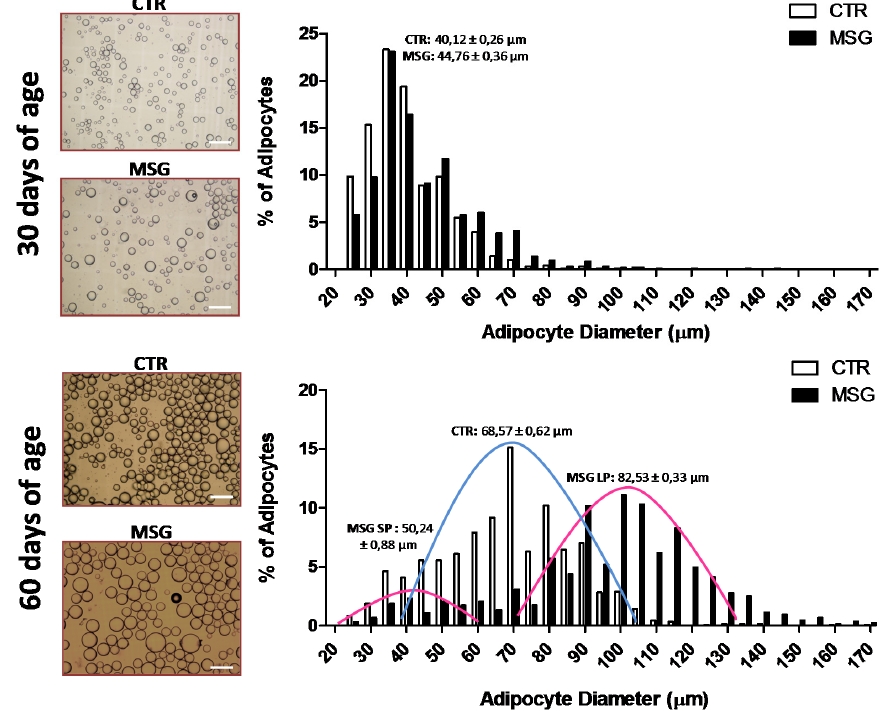
Figure 6. In vivo adipogenesis occurs in MSG animals. Adipocyte size distribution in RPAT depot from CTR and MSG rats at 30 (upper panel) and 60 days of age (lower panel). Purple and blue lines represent MSG (MSG SP: MSG small population; MSG LP: MSG large population) and CTR adipocyte populations, respectively. Representative images of mature adipocytes in cell suspension are shown for each group (magnification 10×, scale bars at 200 μ m). Values are the means ± SEM ( n = 3 animals per group).